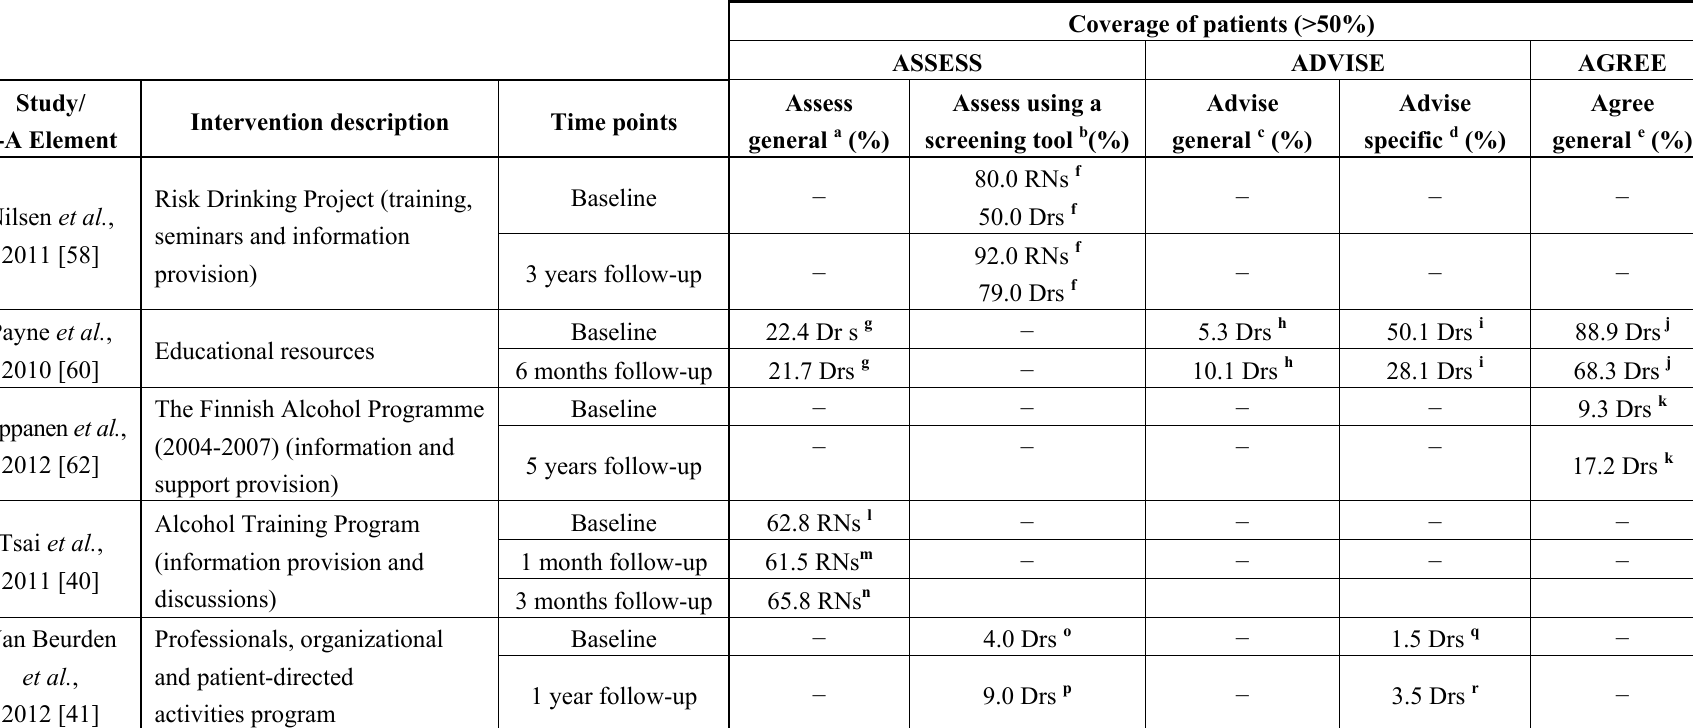
Table 5. A summary of the 5-As * used in alcohol health promotion: The effect of interventions upon professional activity. ( * No data is reported regarding Assist and